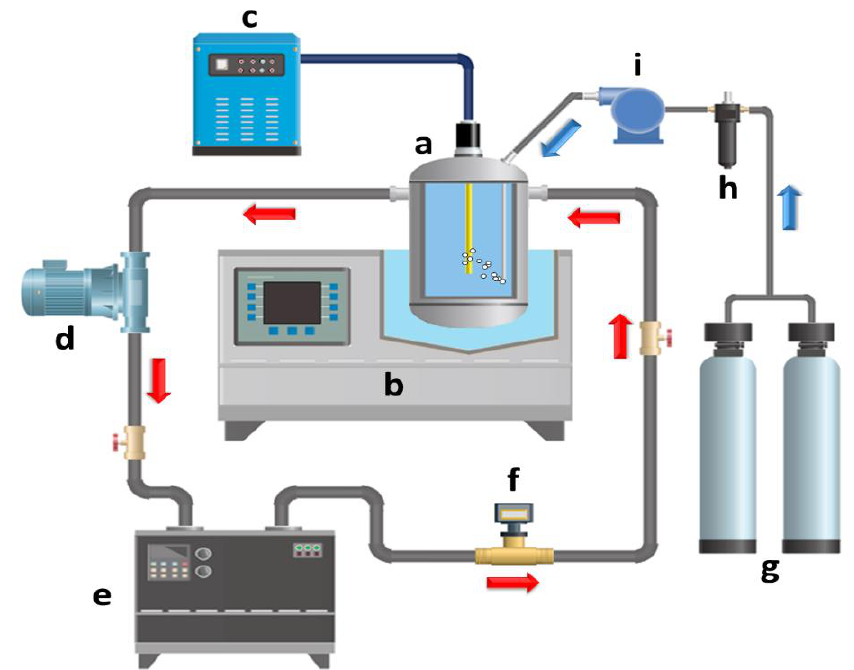
Figure 11. Schematic of the sonophotoreactor setup: (a) photoreactor cell, (b) US bath, (c) UV irradiation control panel, (d) circulation pump, (e) water bath, (f) flow-meter, (g) oxygen gas, (h) gas filter, and (i) oxygen diffuser pump. Reprinted with permission from [47].